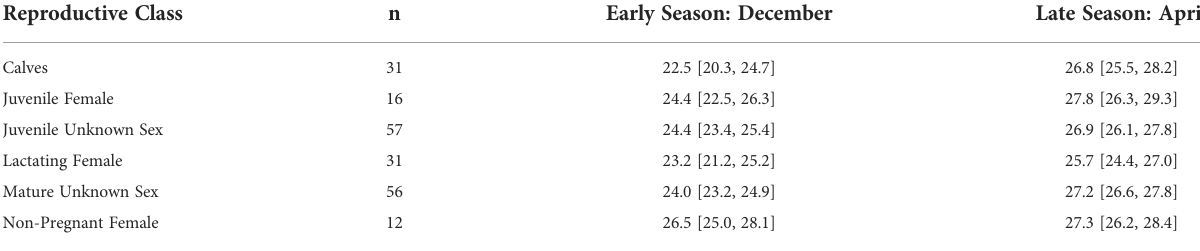
Brackets represent the lower and upper bound of the 95% highest posterior density (HPD) interval.